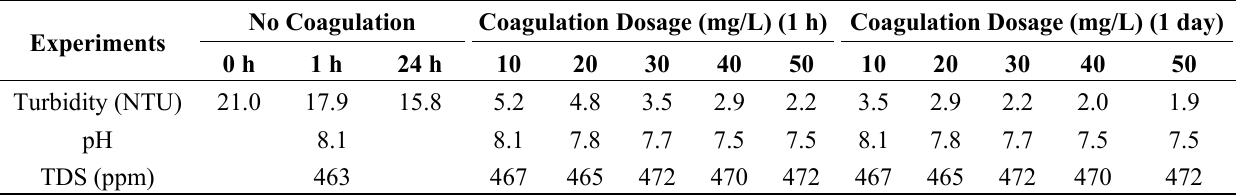
Table 4. Turbidity, pH, and TDS values of lake water as function of Alum addition after 1 h and 24 h settlements by gravity.